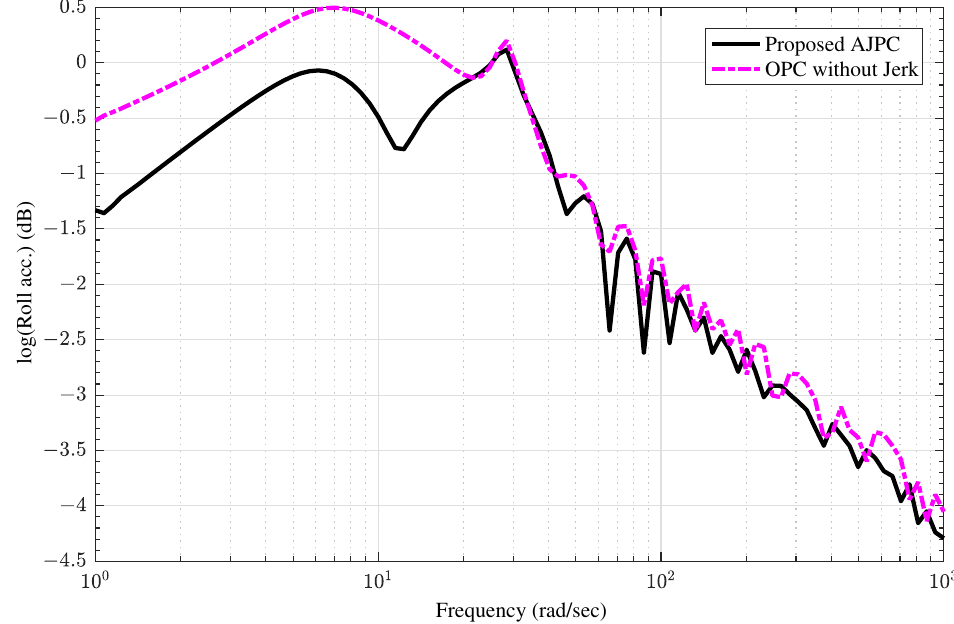
Figure 5. Frequency response comparison of rolling acceleration between proposed AJPC strategy and OPC strategy without